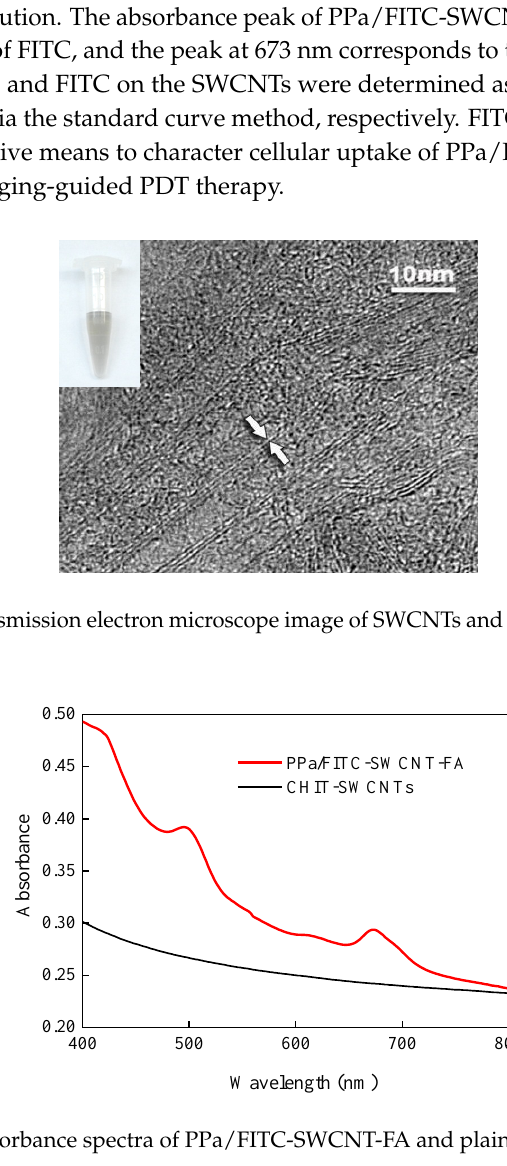
Figure 3. Absorbance spectra of PPa/FITC-SWCNT-FA and plain CHIT-SWCNTs .